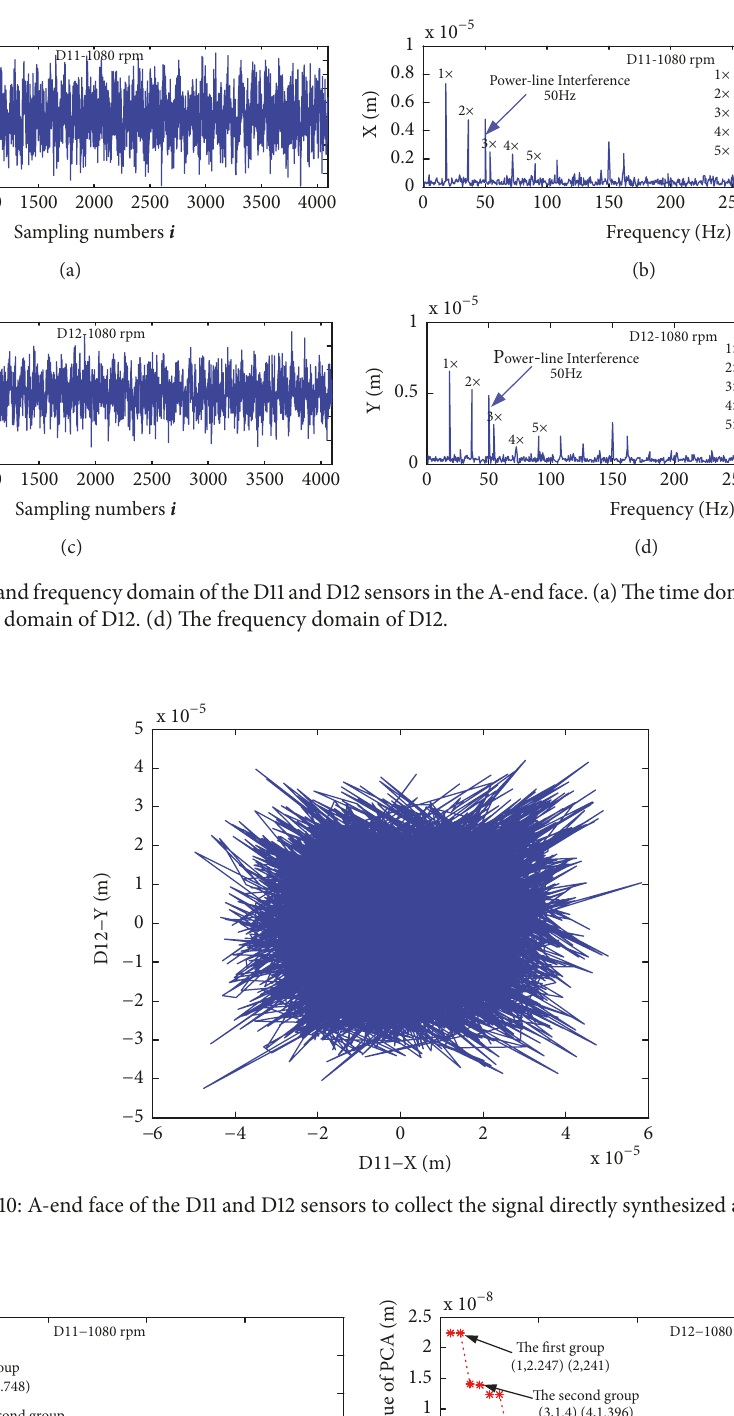
(2,2.748)The first group (1,2.751)